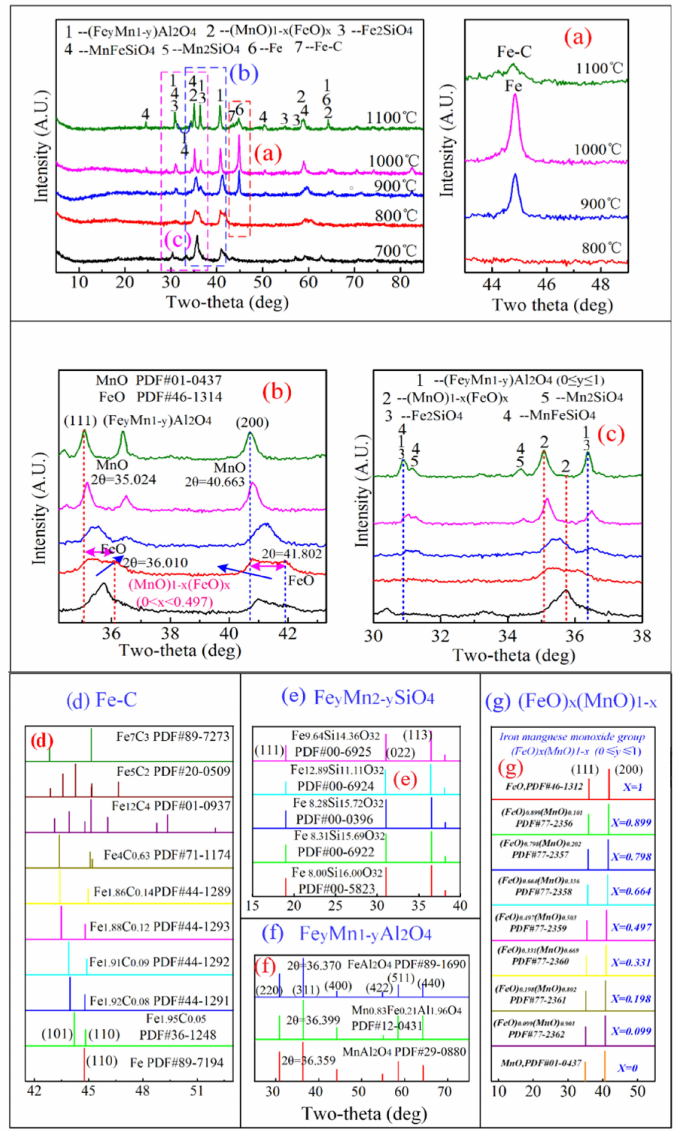
Figure 7. XRD patterns of Fe-Mn ores reduced for 30 min under FC/O of 1.0 at different reduction temperature, ( a ) is the XRD pattern of 2 θ =43 ~ 2 θ =49; ( b ) is the XRD pattern of 2 θ =34.1 ~ 2 θ =43.3; ( c ) is the XRD pattern of 2 θ =30 ~ 2 θ =38 and XRD patterns of standard substances of the ( d ) Fe x C group, ( e ) Fe y Mn 2 − y SiO 4 group, ( f ) (Fe y Mn 1 − y )Al 2 O 4 group and ( g ) (FeO) x (MnO) 1-x